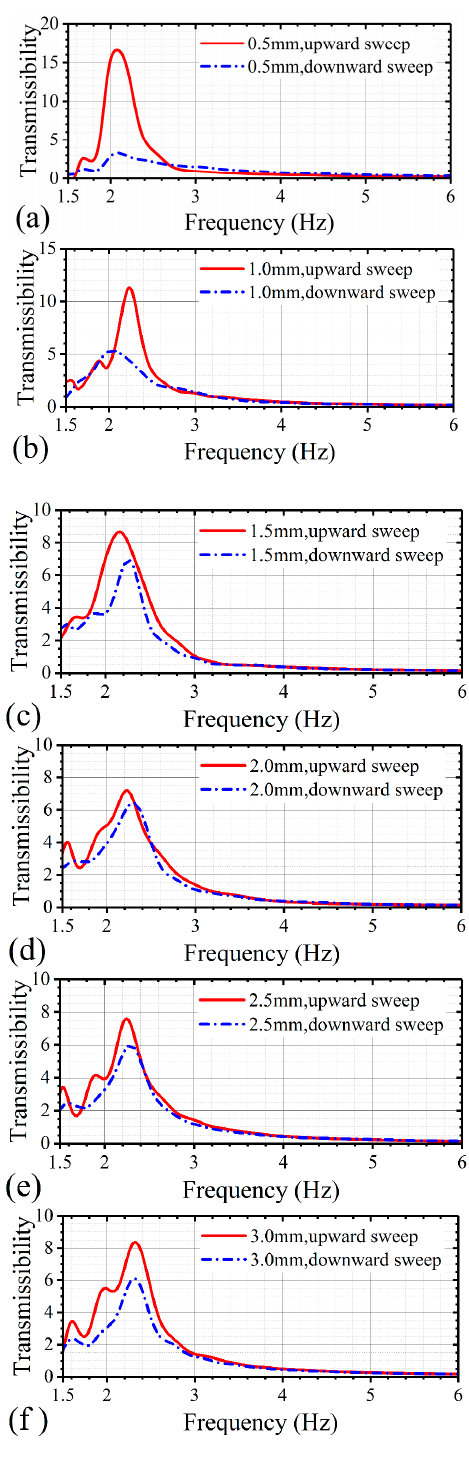
Figure 11. Acceleration transmissibility of the geometric anti-spring isolator under linear frequency sweep excitation with different excitation displacement amplitudes. The excitation displacement are: ( a ) 0.5 mm, ( b ) 1.0 mm, ( c ) 1.5 mm, ( d ) 2.0 mm, ( e ) 2.5 mm and ( f ) 3.0 mm, respectively.